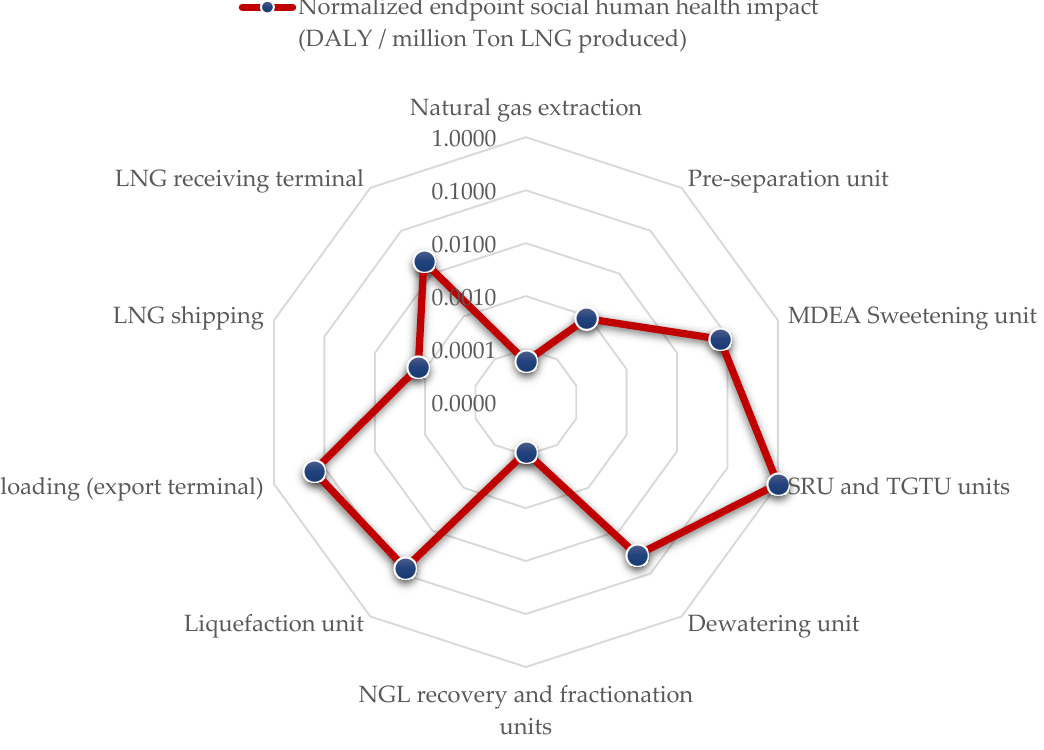
Figure 16. Normalized midpoint air emissions comparison of the LNG supply chain.